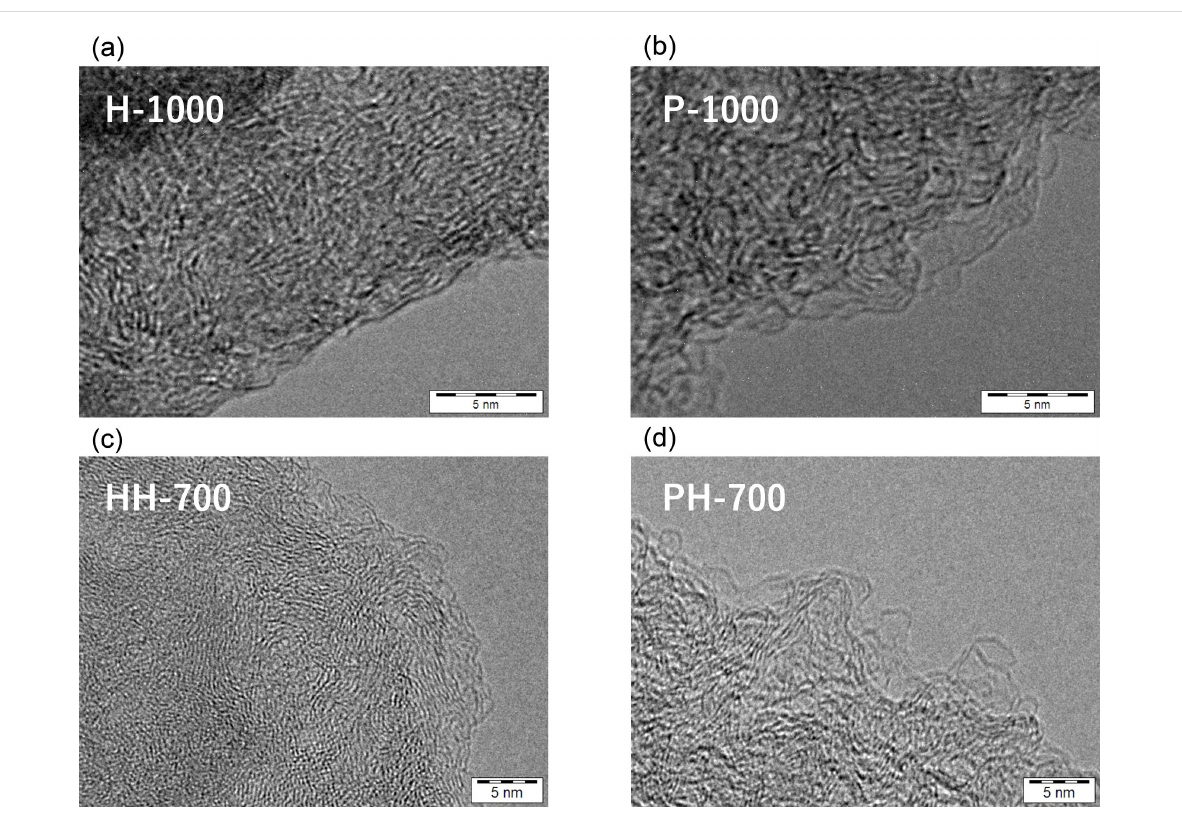
Figure 1: TEM images of the carbon materials. (a) H-1000, (b) P-1000, (c) HH-700, (d) PH700.